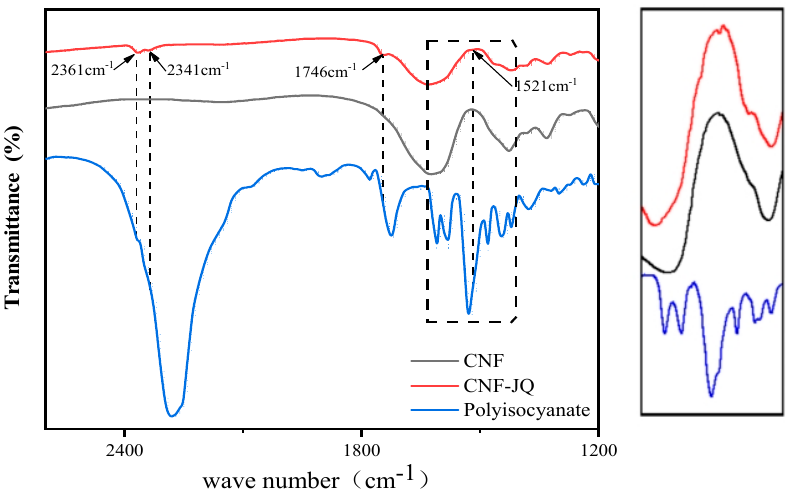
Figure 3. FTIR spectra of CNF, polyisocyanate, and CNF − JQ.